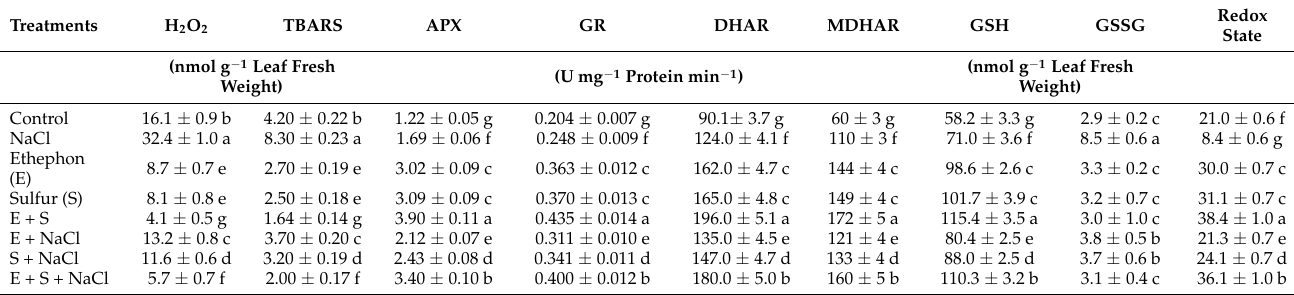
Table 2. Content of H 2 O 2 , TBARS, activity of APX, GR, DHAR and MDHAR and GSH content and redox state (GSH/GSSG) in mustard leaves at 30 days after sowing. Plants were treated with 200 µ L L − 1 ethephon and/or 200 mg S kg − 1 soil (S) in presence or absence of 100 mM NaCl. Data are presented as means ± SE ( n = 4). Data followed by same letter are not significantly different by LSD test at p < 0.05. APX, ascorbate peroxidase; GSH, reduced glutathione; DHAR, dehydroascorbate reductase; GR, glutathione reductase; H 2 O 2 hydrogen peroxide; MDHAR, monodehydroascorbate reductase; GSSG, oxidized glutathione; TBARS, thiobarbituric acid reactive substances. Treatments H 2 O 2